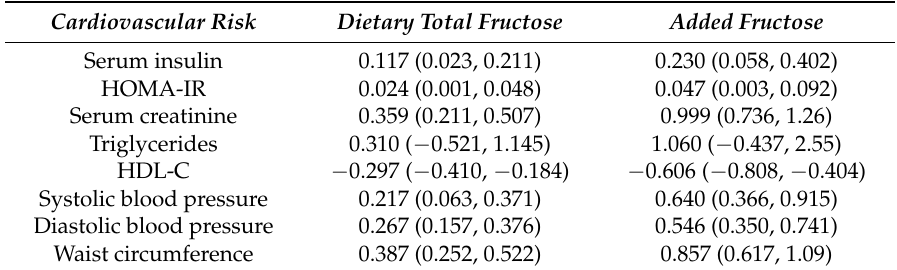
Table 3. The association of fructose intakes and changes of cardiovascular risk factors during the study